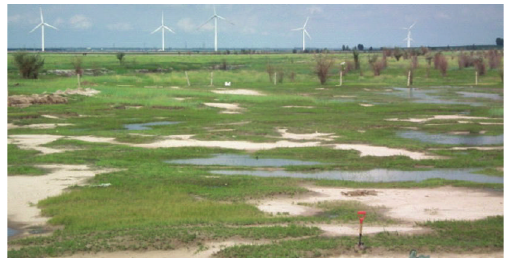
Figure 11: The landscape of saline-alkali soil in the research area.